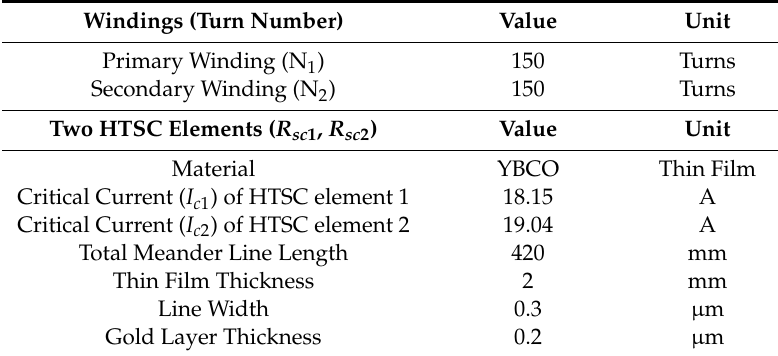
Table 1. Specifications of bridge type SFCL with simultaneous quench using flux-coupling. HTSC = high-temperature